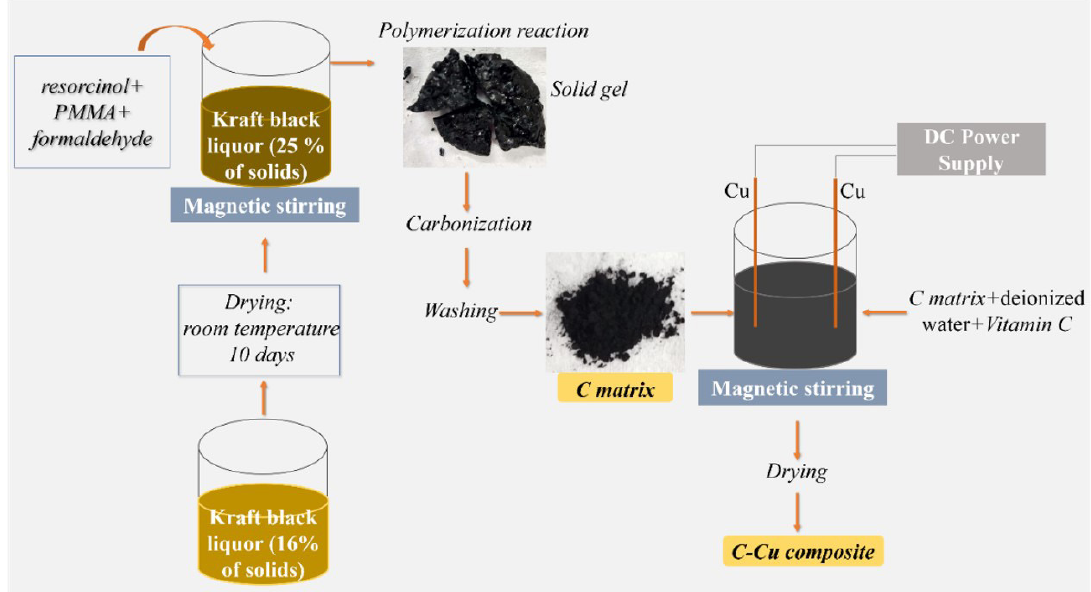
Figure 1. Schematic illustration of the synthesis of C matrix and C–Cu